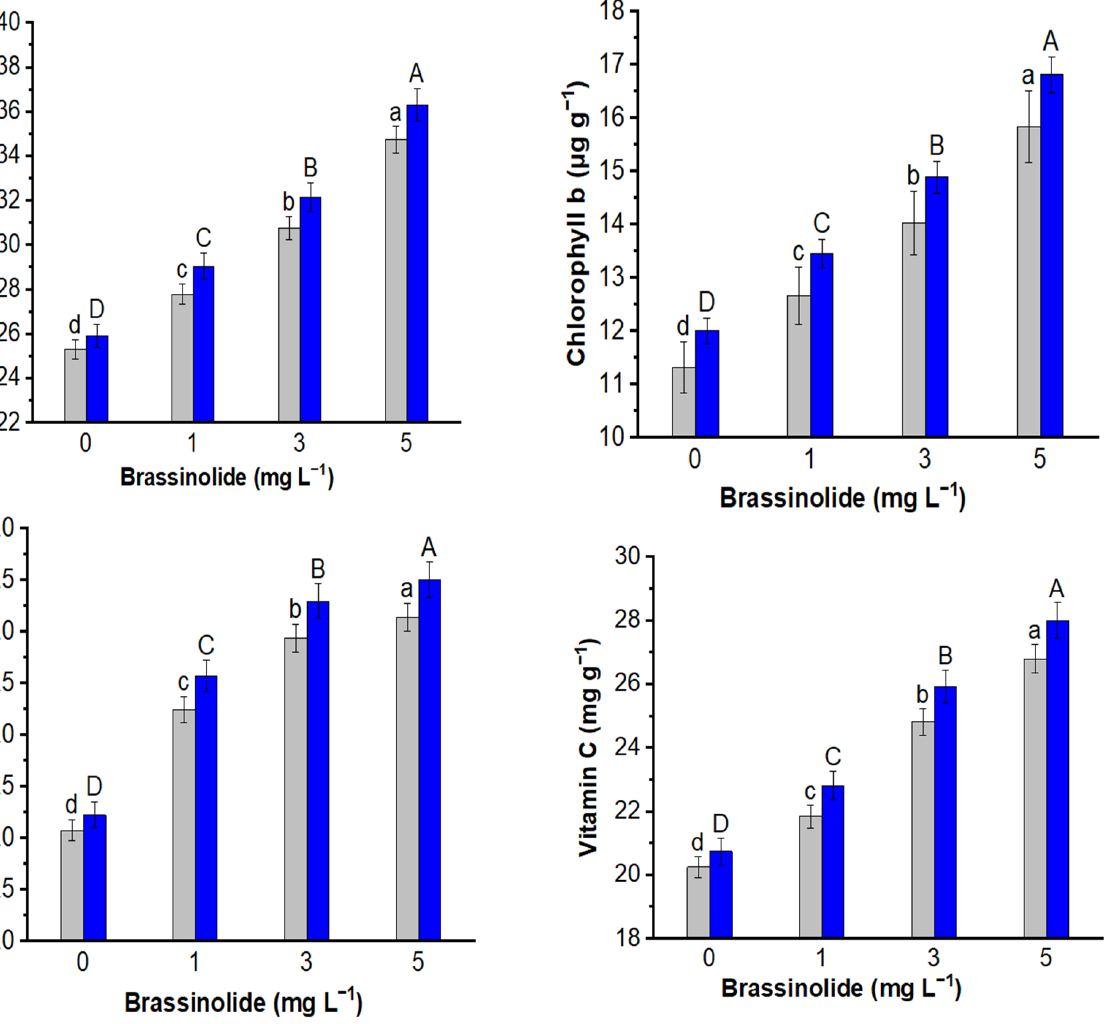
Figure 5. Chlorophyll a (µg g − 1 ), chlorophyll b (µg g − 1 ), protein content (%), and vitamin C (mg g − 1 ) of Opuntia ficus-indica L. plants subjected to brassinolide foliar spray. Data are mean value ± SE. Bars with the same letters (lowercase for the first season and uppercase for the second season) are not significant at p ≤ 0.05